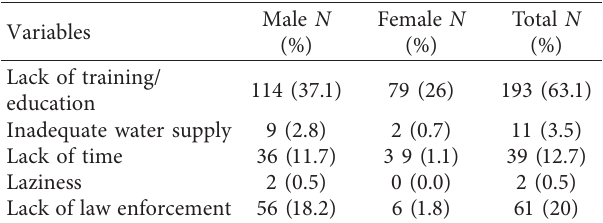
Table 5: Barriers to food safety.